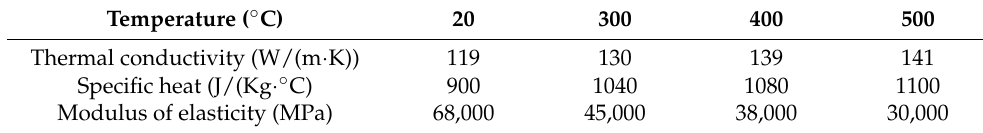
Table 2. Thermal and physical properties of 6016 aluminum alloy.